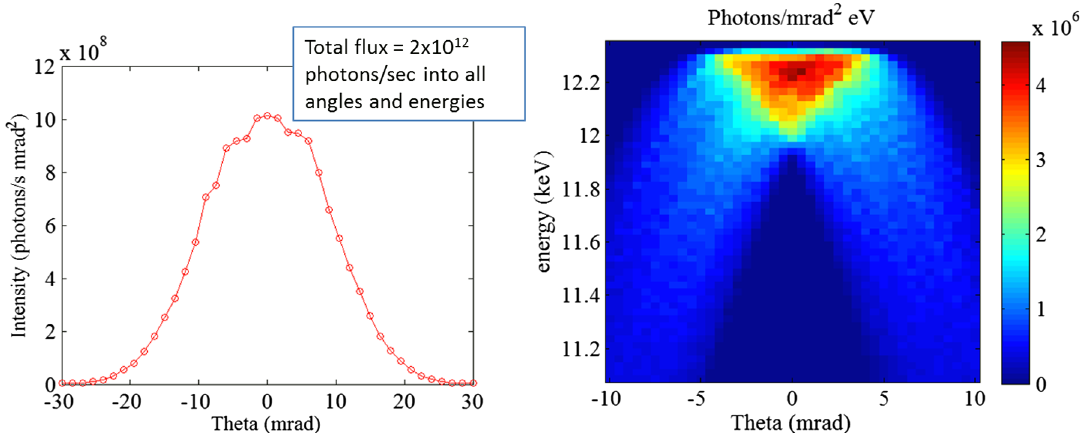
FIG. 4. Plots of total x-ray output near 12 keV. The flux at 100 kHz is 2 × 10 12 photons = sec into all angles and energies. The left plot shows flux vs angle and the right plot shows color coded intensity vs angle and photon energy. The on-axis bandwidth is represented by the vertical width of the higher intensity area at θ ¼ 0 , and is narrower than the total bandwidth over all angles. The off-axis photons are lower energy and wider bandwidth than on-axis